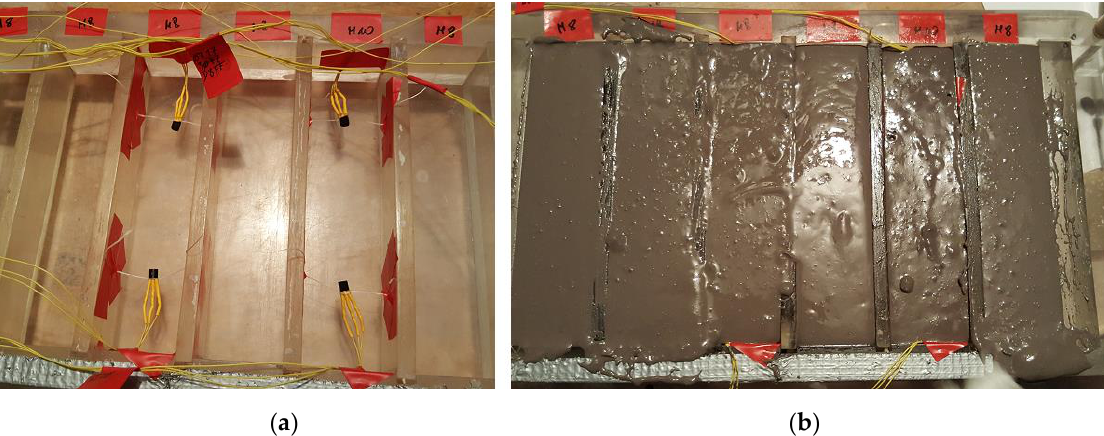
Figure 2. The measurement of temperature changes in samples during the curing process: ( a ) thermometers inside the empty molds; ( b ) fresh geopolymer mixture inside the molds.